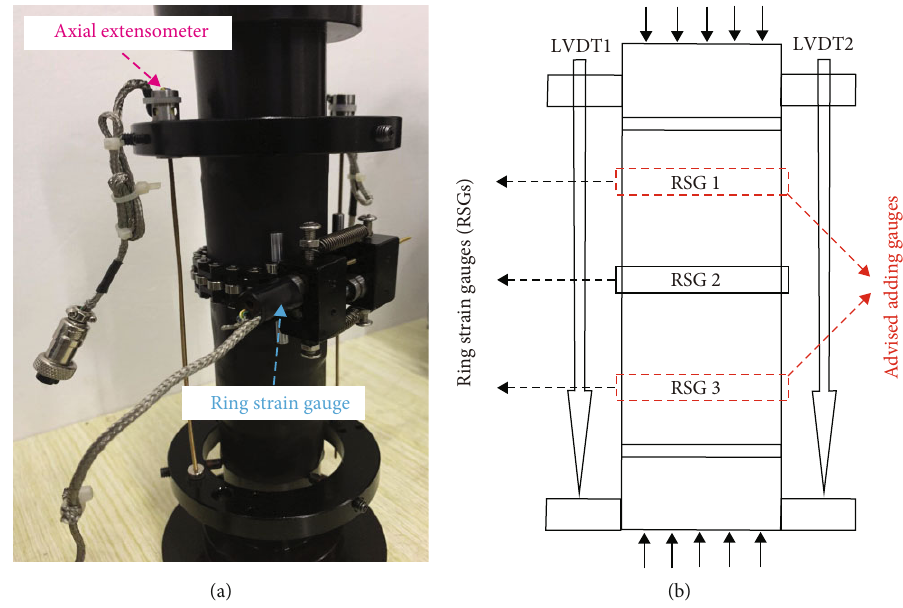
Figure 9: The measuring method of the lateral strain before (a) and after (b)